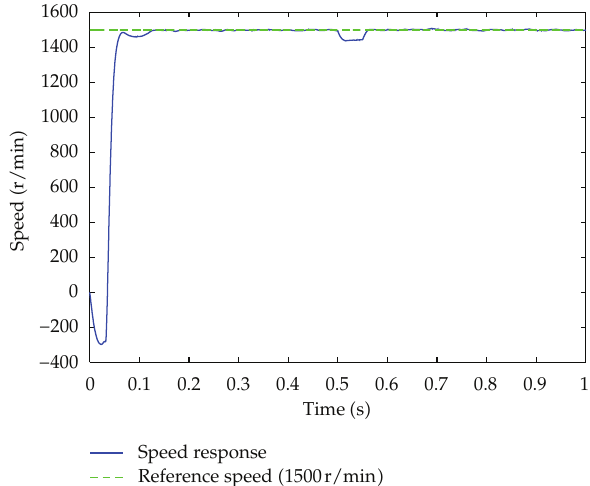
Figure 7: Speed response under the network delays and dropouts and the load torque